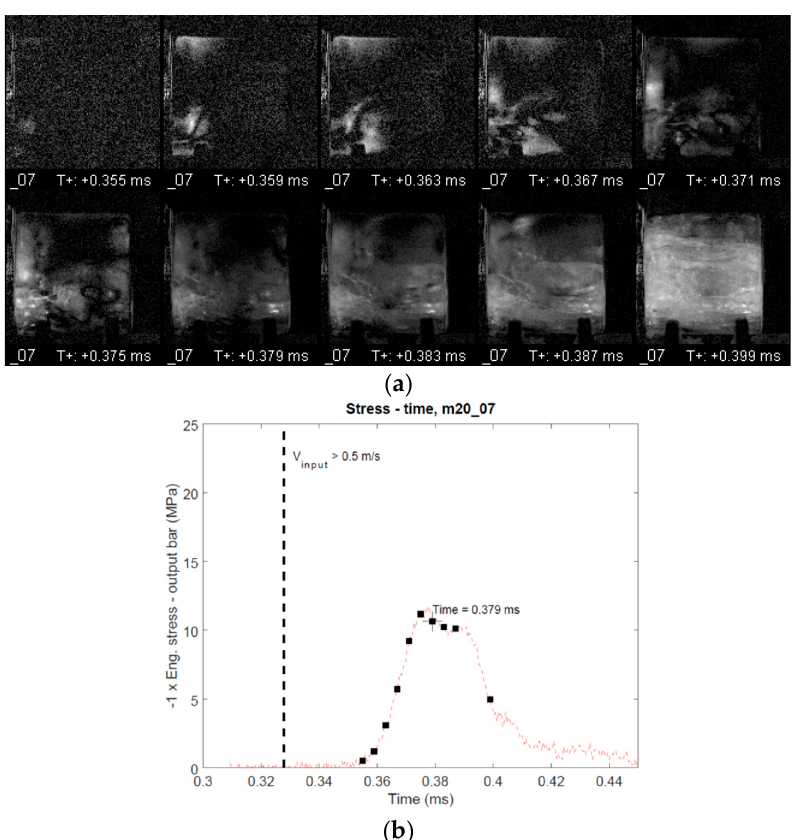
Figure A4. ( a ) processed high speed footage obtained in the high rate test m20_07, ( b ) corresponding specimen stress-time signal obtained from the output bar strain gauge measurement (synchronized with high speed footage). The input bar is located on the left-hand side of the figure in ( a ). The time, at which the input bar end velocity exceeded 0.5 m/s as well as the times corresponding to the high speed frames are marked on the respective stress-time curve.